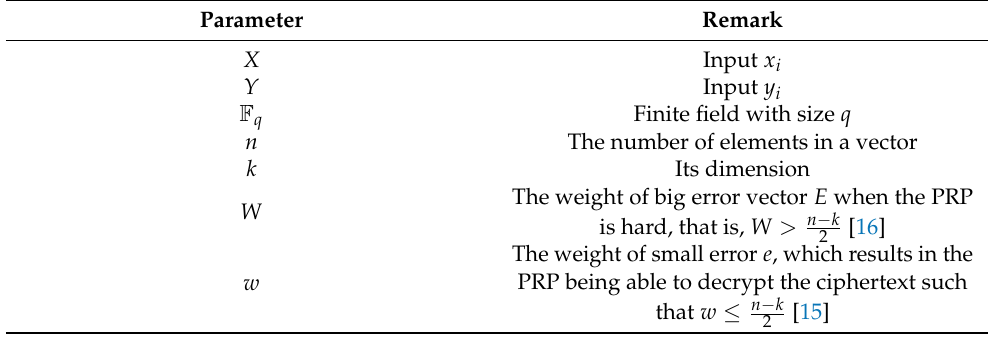
Table 1. Parameters used in the